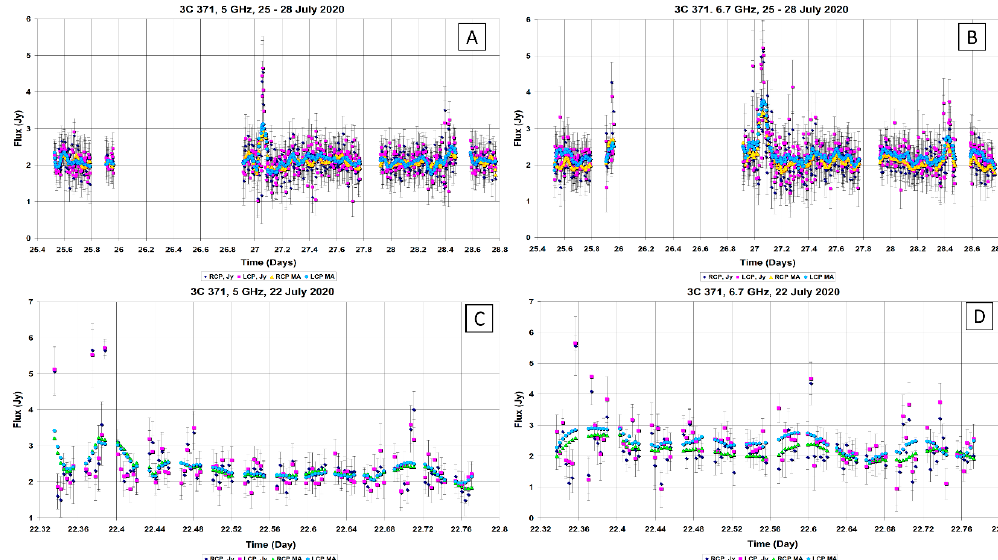
Figure 6. Plots of flux density variations of 3C 371, 22 July 2020 at 5 GHz ( C ) and 6.7 GHz ( D ), as well as plots of flux density variations from 25 to 28 July 2020 at 5 GHz ( A ) and 6.7 GHz ( B ). The figures also show smoothed data, for left (LCP) and right (RCP) circular polarizations. It can be seen that the amplitude (for smoothed data) of irregular variations in the flux density almost does not exceed 0.5 Jy, with an amplitude of bursts, about 1 Jy, as in other observation sessions. The average flux density for 25–28 July, at a frequency 5 GHz, was 2.118 ± 0.420 Jy (RCP) and 2.127 ± 0.418 Jy (LCP). Over the same time interval, at a frequency 6.7 GHz, the average flux density was 2.145 ± 0.451 Jy (RCP) and 2.287 ± 0.480 Jy (LCP).